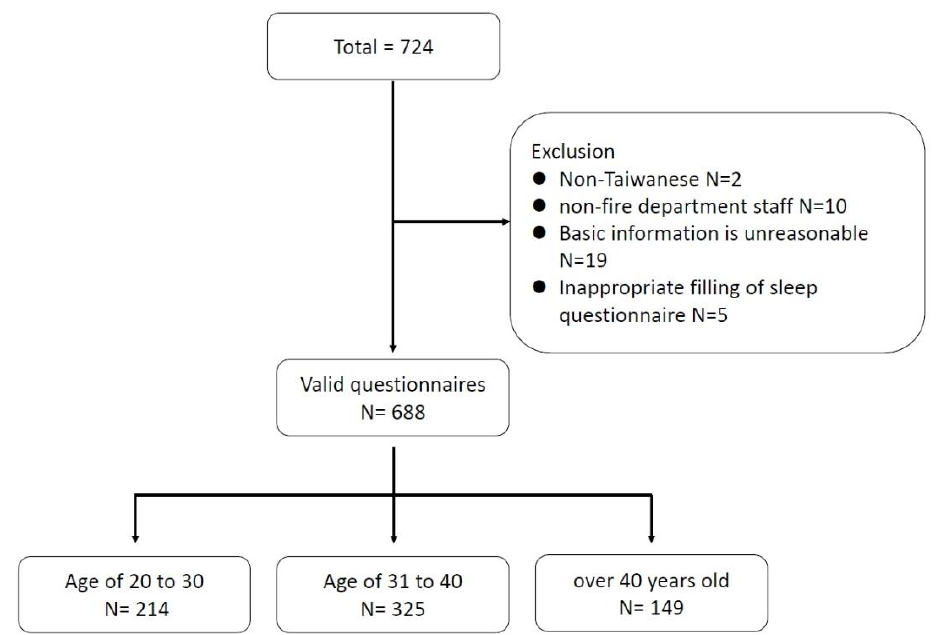
Figure 1. Diagram of the study participants’ selection process .